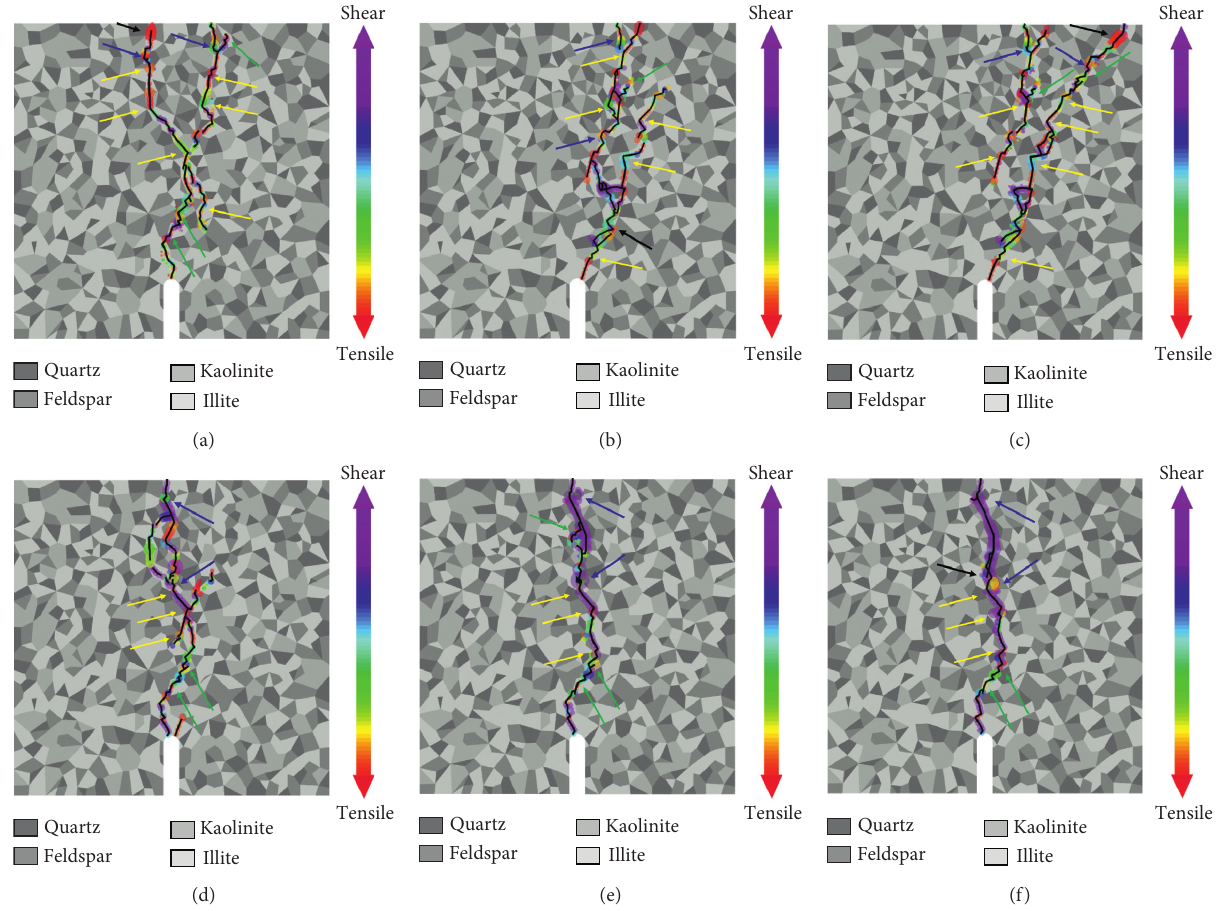
Figure 9: AE location on the fracture path under six different load methods. The yellow arrows refer to the crack growth in a wide region of kaolinite and illite, the green arrows refer to the crack growth in a small region of kaolinite and illite that was surrounded by quartz and feldspar, the blue arrows refer to the crack growth in the boundary of different minerals, and the black arrows refer to the crack growth in quartz and feldspar. Red dots are the AE location of tensile fractures, purple dots are the AE location of shear fractures, and the colors between the two are the AE location of tensile-shear fractures. The size of the dot represents the level of AE